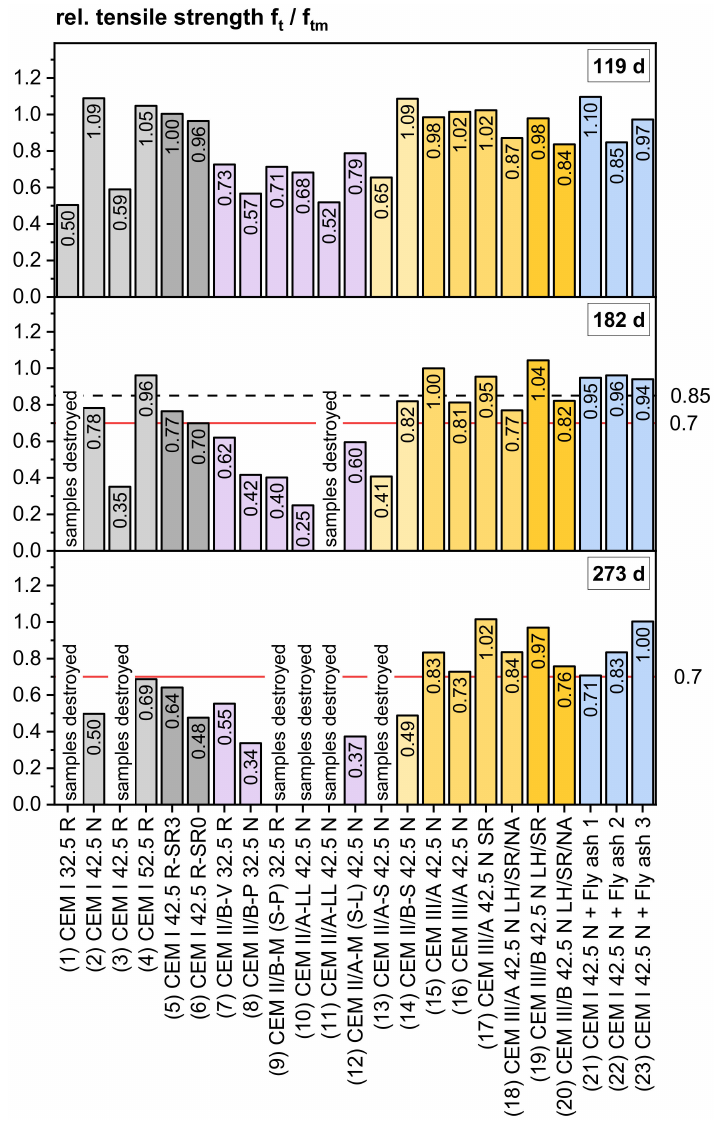
Figure 2. Relative tensile strength f t /f tm of concrete with 23 different binders after 119, 182 and 273 days (grey: Portland cement, purple: CEM II, yellow: slag cement, blue: Portland cement + fly ash; average coefficients of variance: σ 119d = 9.4%, σ 182d = 10.2%, σ 273d =